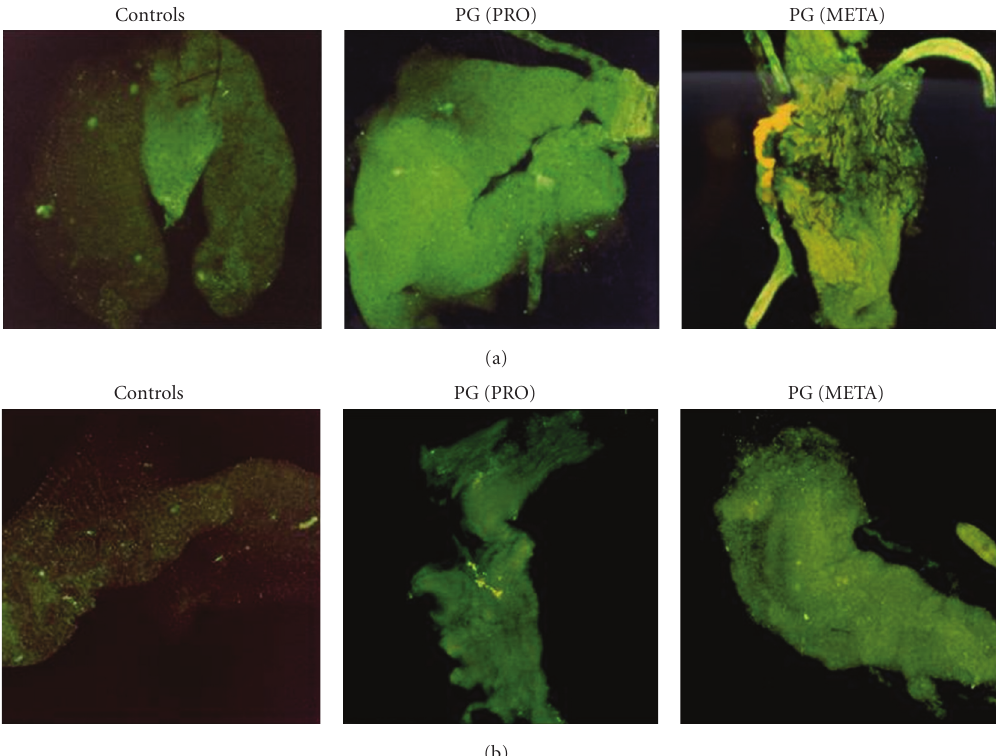
Figure 4: Fluorescent staining of L. intermedia (a) and L. whitmani (b) midguts incubated with PGs from procyclic (PRO) and metacyclic (META) L. braziliensis , probed with CA7AE antibody (1:400) and developed with FITC (1:1000). Control midguts were incubated with primary and secondary antibodies